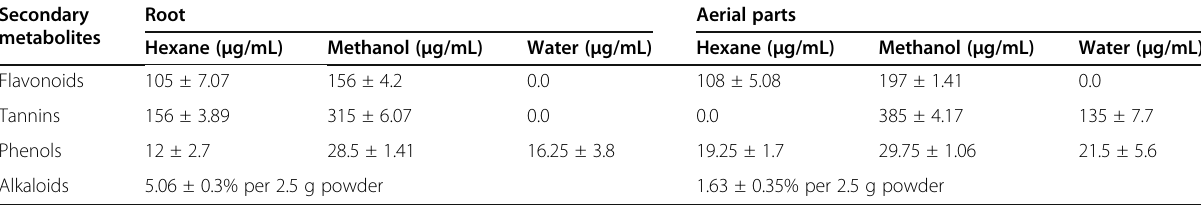
Table 2 Quantitative phytochemical analysis of root and aerial parts of V . coriaceum Secondary